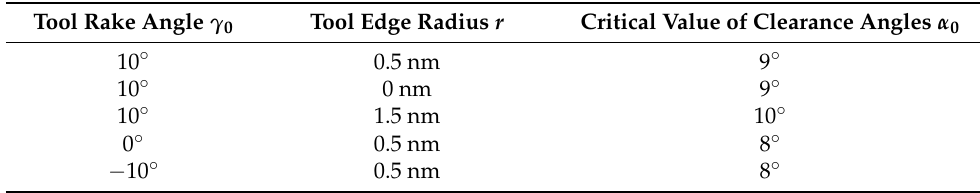
Table 2. Clearance angle critical value